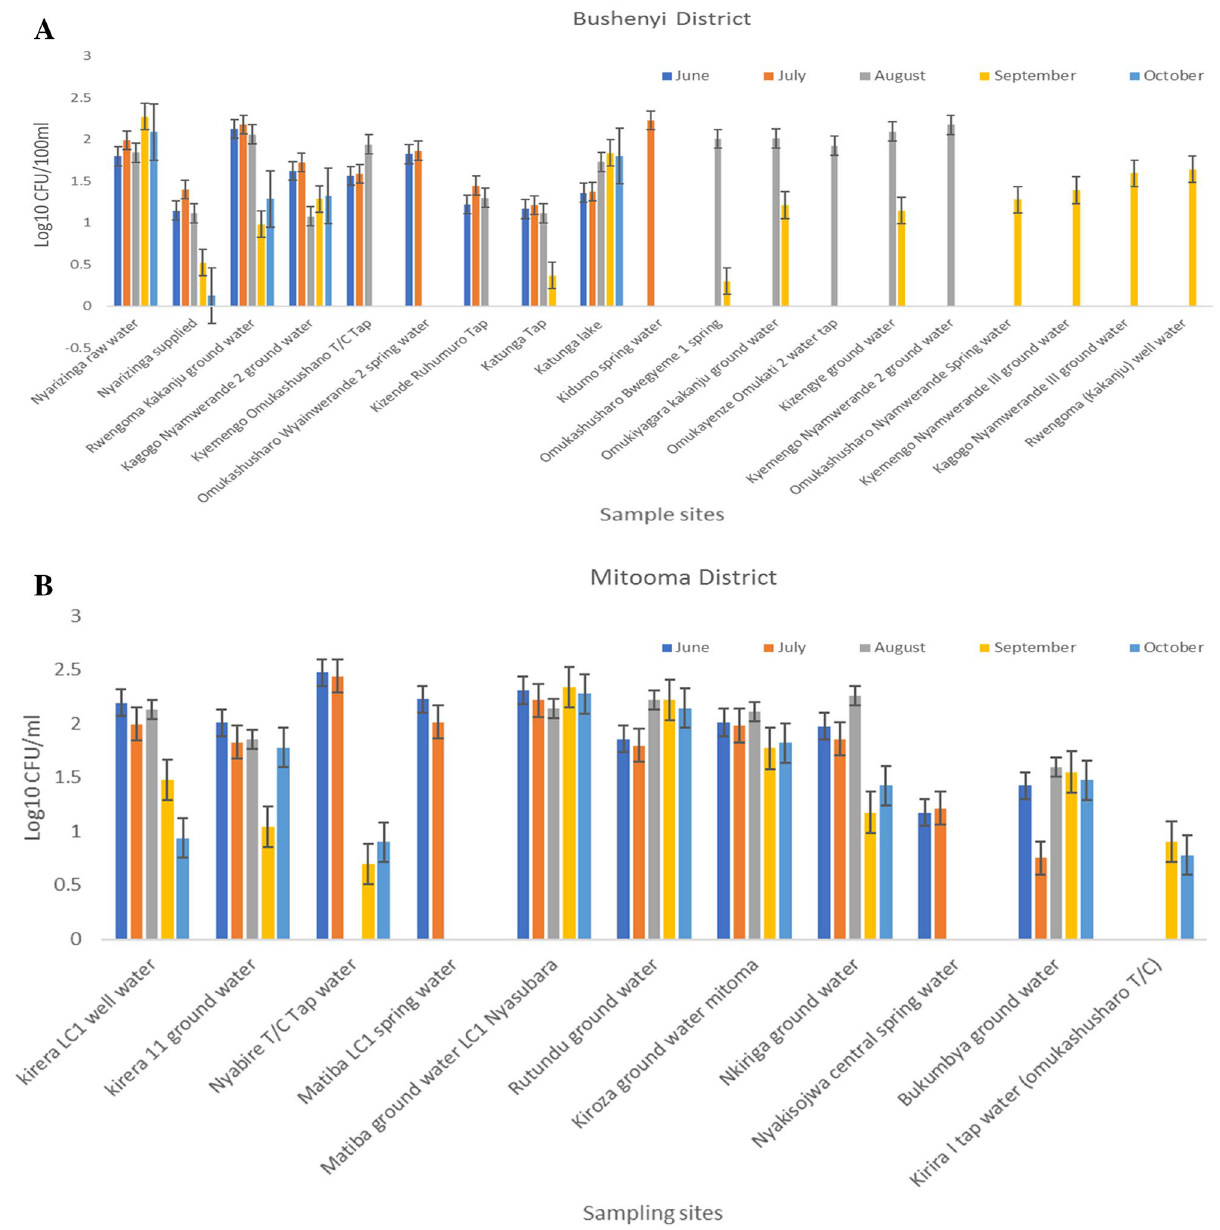
Figure 2. ( A ) Presumptive Vibrio counts from 19 selected sampling points in Bushenyi subcounties. The graph shows a plot of the seasonal average of log10 CFU/100 ml for Vibrio counts over the period of